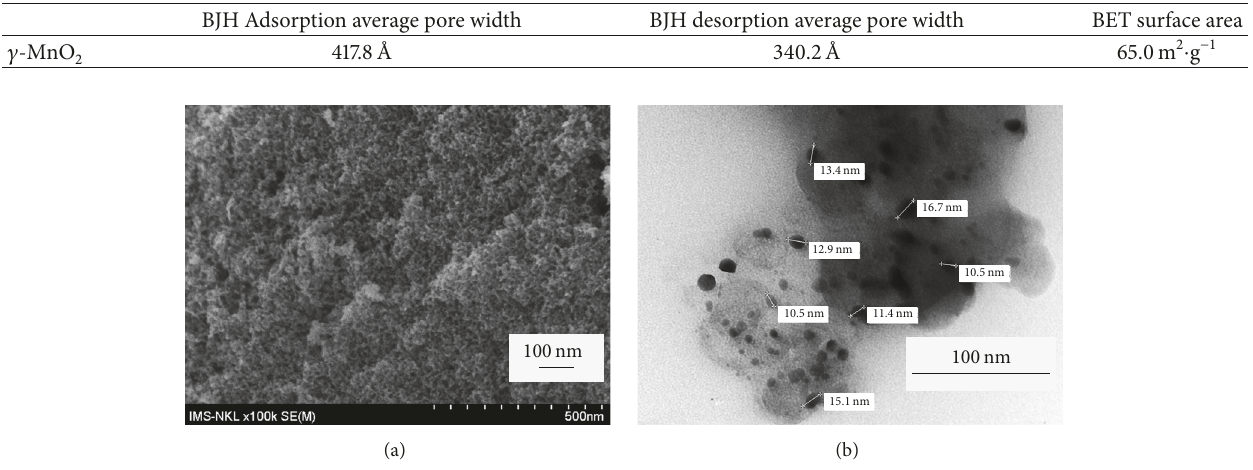
Table 2: The BET and BJH analytical results.